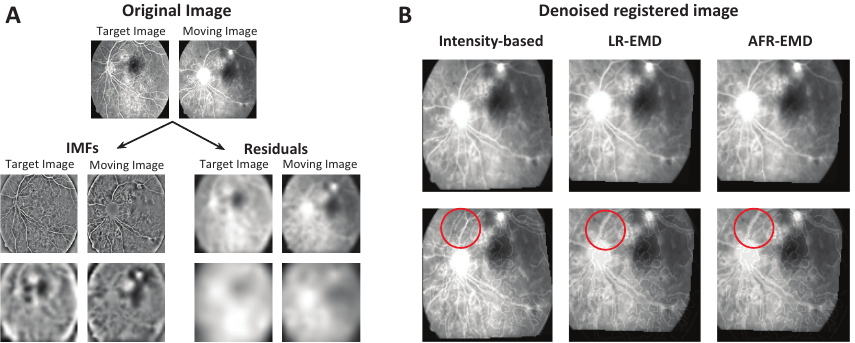
Figure 10. Registration of Retina images taken 2 years apart. ( A ) The set of IMFs and residuals for two levels of EMD are shown for both target and moving images. ( B ) Registered images using our two methods and intensity-based hierarchical algorithm. The second row shows the composite view through contour overlap after the